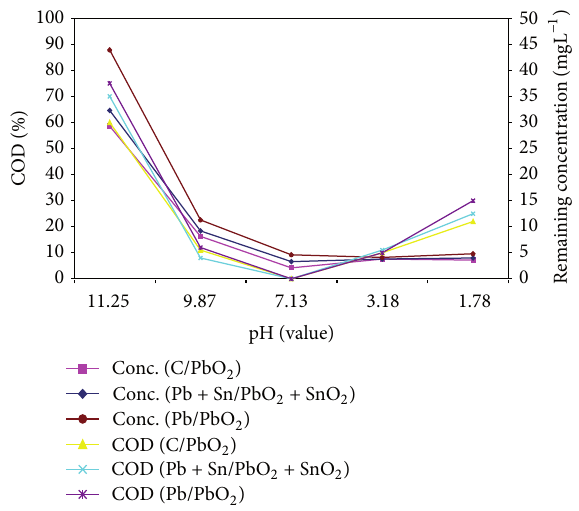
F 1: e effect of pH on RY160 and COD removal using C/PbO 2